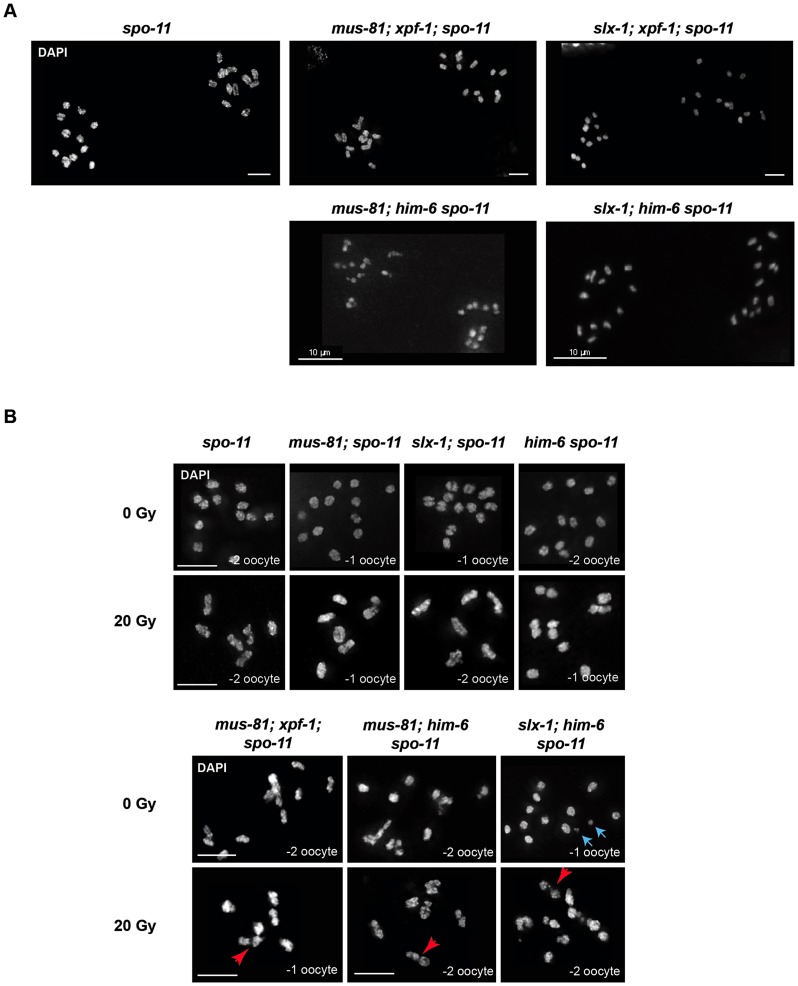
Chromosome linkages depend on SPO-11-induced meiotic double-strand breaks.(A) Images of DAPI-stained -1 and -2 oocytes (position distal to spermatheca) of the indicated genotypes. Scale bars are 4 µm unless indicated otherwise. (B) Irradiation induced double-strand breaks bypass the SPO-11 requirement. Red arrows indicate chromosome linkages. Blue arrows indicate DNA fragments, which we observed in [slx-1; him-6 spo-11] but not in [slx-1; him-6]. Scale bars are shown in white (5 µm).